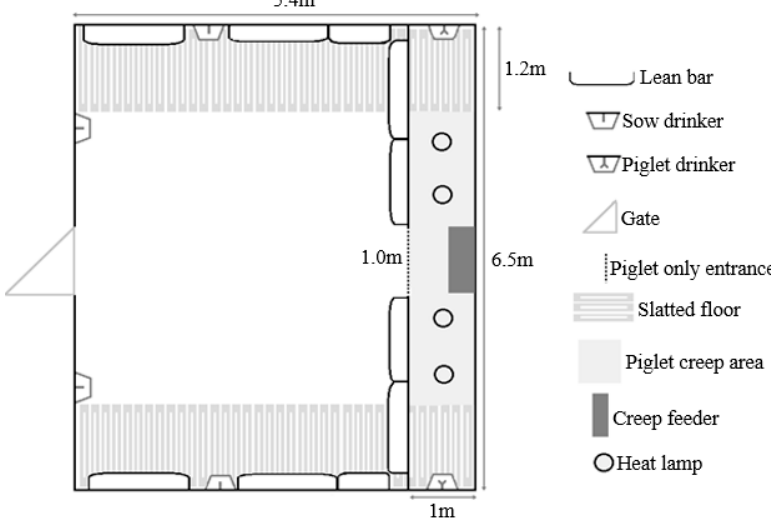
Figure 2. Diagram of the layout of the multisuckle treatment (MS) housing (with 6 sows and litters per group).